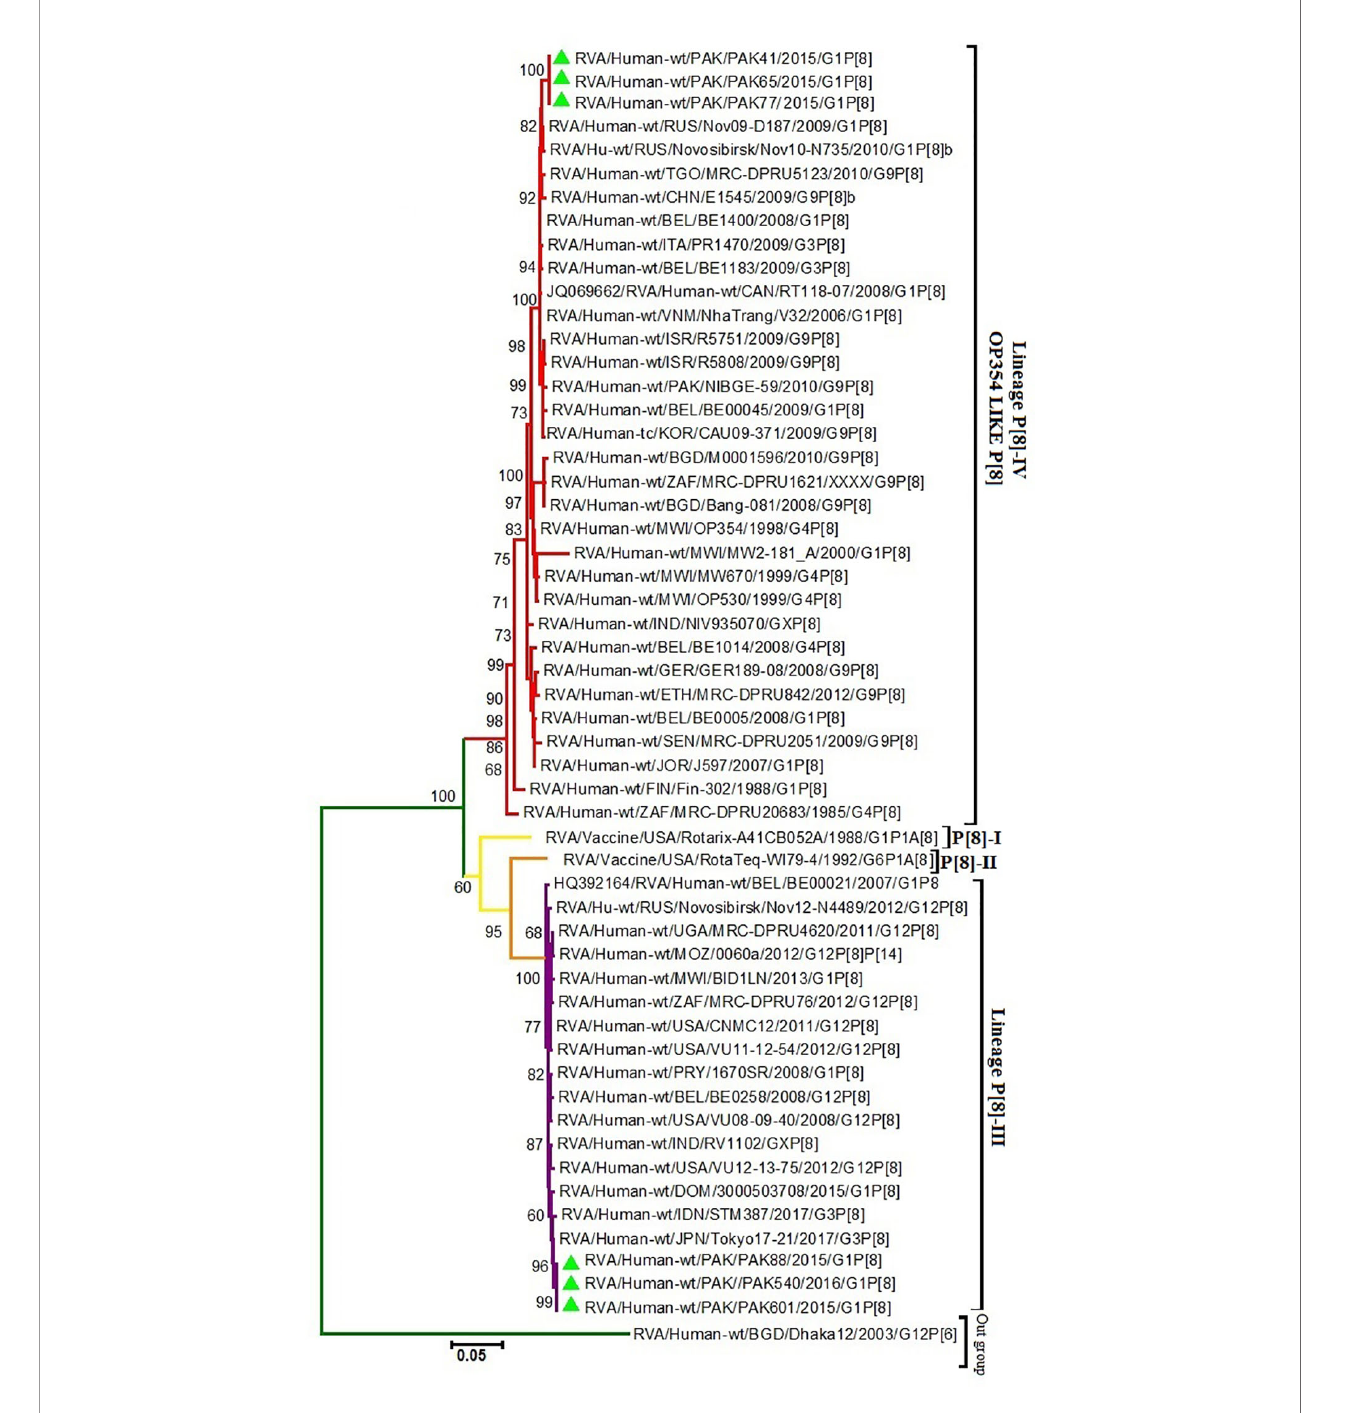
FIGURE 3 | Maximum Likelihood Phylogenetic tree of the VP4 protein of G1P[8] Group A rotavirus (RVA) strains reported in Pakistan and the vaccine strains Rotarix ™ and RotaTeq ™ . Maximum Likelihood trees were generated using Kimura-2-parameter model in MEGA 6. Coloured branches represent different lineages. Yellow colour branch includes strains belong to lineage I and orange colour branch represent lineage II strains. The lineage III is represented by Purple colour branch including strains isolated from all over the world and our study strains represented by green triangles in the same branch. The lineage IV is represented by Red colour branch including strains isolated from all over the world and our study strains represented by green triangle in the same branch. RVA strain (G12P[6]) from Bangladesh is used as an as out-group is represented by green colour branch in the tree. Bootstrap replicates (1000) below than 60% are not shown in the